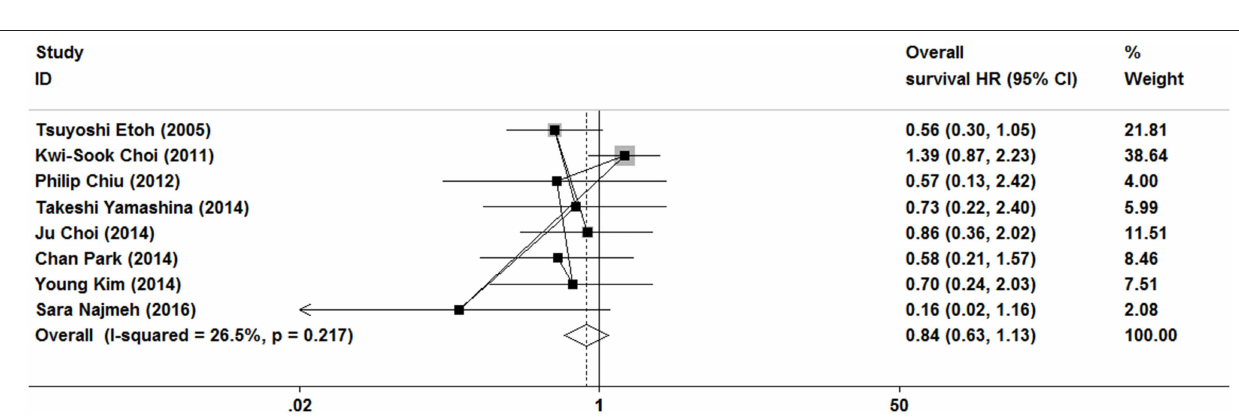
accepted due to its minimal invasiveness and better quality of minimal treatment for early gastric cancer